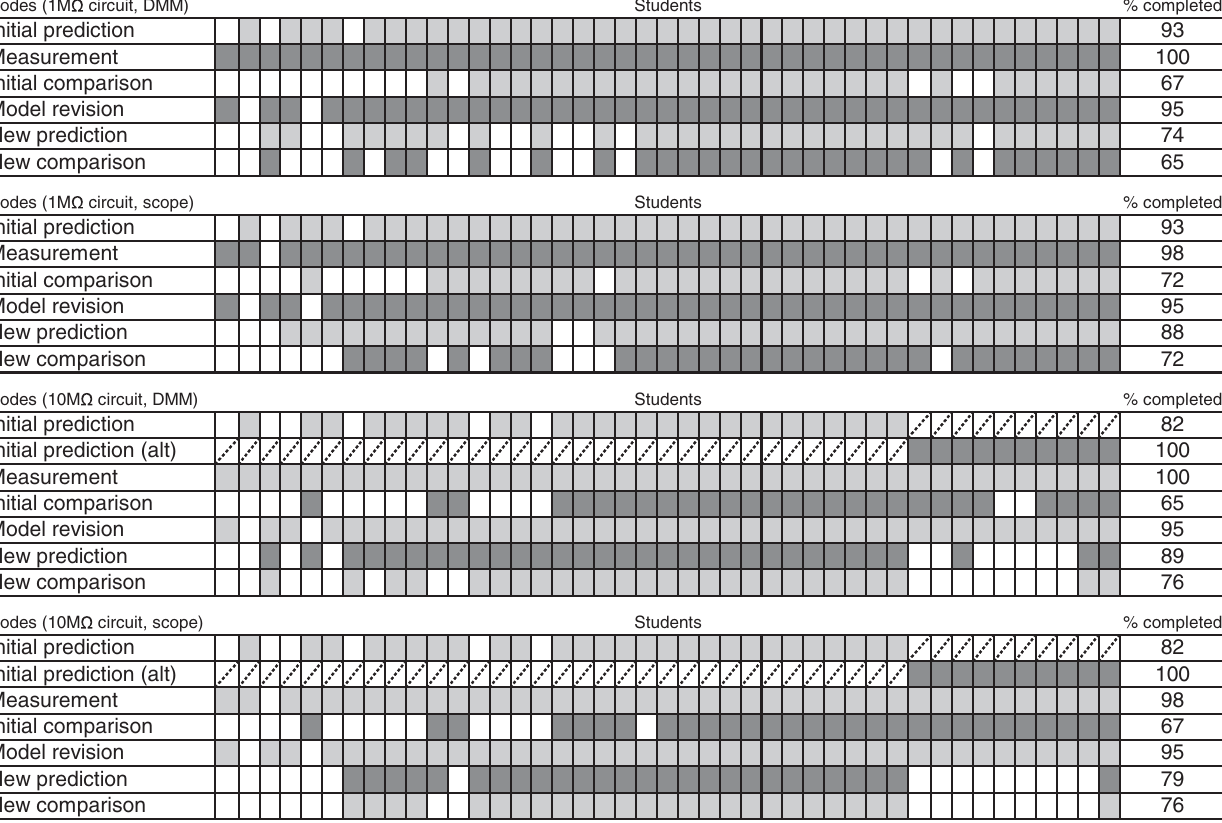
FIG. 5. Coding results for the four parts of Activity 1. The top (bottom) two diagrams show the coding results for the 1 M Ω ( 10 M Ω ) circuit measured with the DMM. The results for the oscilloscope measurements of the same circuits demonstrated essentially the same degree of completion. In total, 37% of the students documented the modeling process for the entire activity (all four parts). Rows represent different steps in the modeling process and columns represent individual students (the corresponding column of each of the four diagrams represents the same student). Each gray box represents a documented instance of the corresponding modeling step for the corresponding student. The diagonal hash marks indicate that the two different initial predictions represented two separate modeling pathways and thus no student would do both. Rightmost column represents percentage of students who documented that step of the modeling process. The percentages for the initial predictions are based on the total number of students who chose one of the two modeling